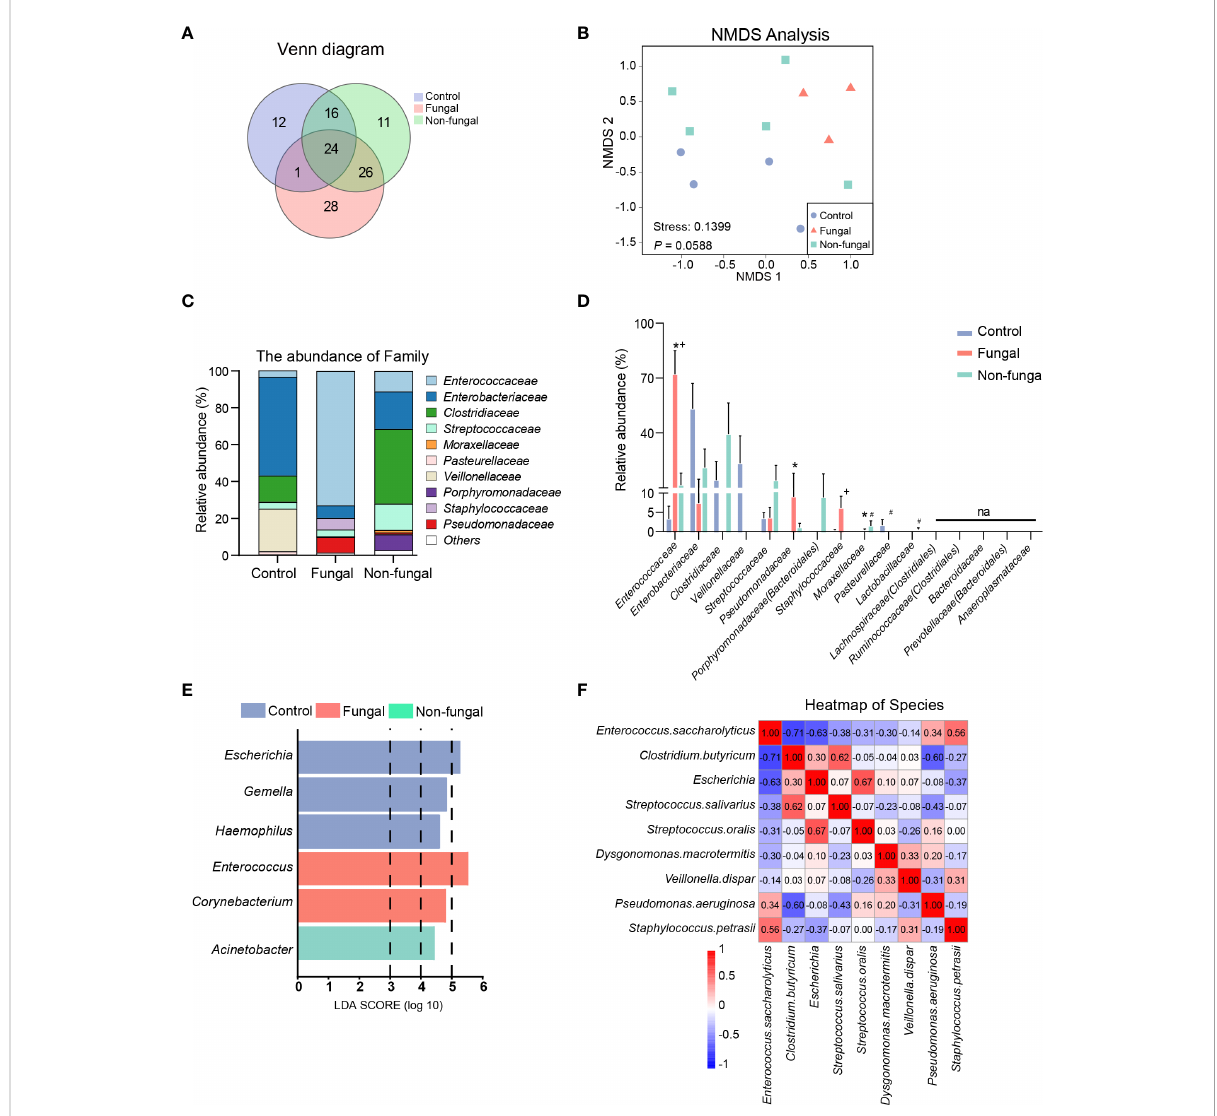
FIGURE 2 Evaluation of microbiome composition in newborns without antibiotics and without fungal infection (control group), newborns treated with antibiotics (non-fungal group) and newborns infected with fungi (fungal group). (A) A Venn diagram shows the common and unique OTUs of the three groups, where Core represents the common OTUs of the three groups. (B) Nonmetric Multidimensional Scaling (NMDS): groups were compared using ANOSIM. Relative proportions of sequences read at the family (C) levels assigned to different bacteria. The microbiome abundance was less than 0.5% in all samples, and the unannotated microbiomes were all merged into Others. Comparison of relative abundance of bacteria at family (D) levels. The results are mean ± SEM, and the P values of the differences between groups were tested by the